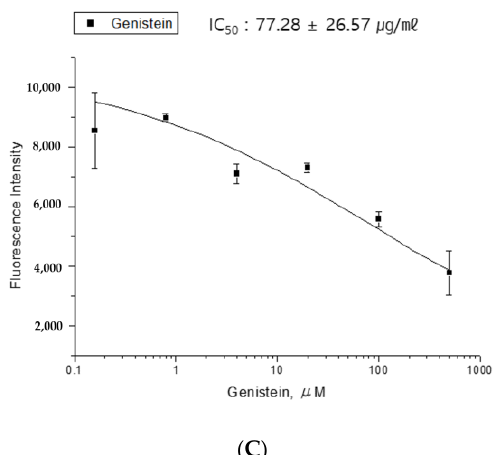
Figure 1. Dose–response curve and half-maximal inhibitory concentration (IC50) of GM ( B ) and GE ( C ) in the 5-HT2C receptor binding assay. For screening effective antagonists to the 5-HT receptor, GM and GE were reacted to a Protein Chip bound to 5-HT2c receptors, and then Cy5-tryptamine was added ( A ). Red color represents fluorescence intensity to Cy5-labeled tryptamine alone bound to 5HT2c receptors, and yellow color represents competitively drug-induced inhibitory binding activity.